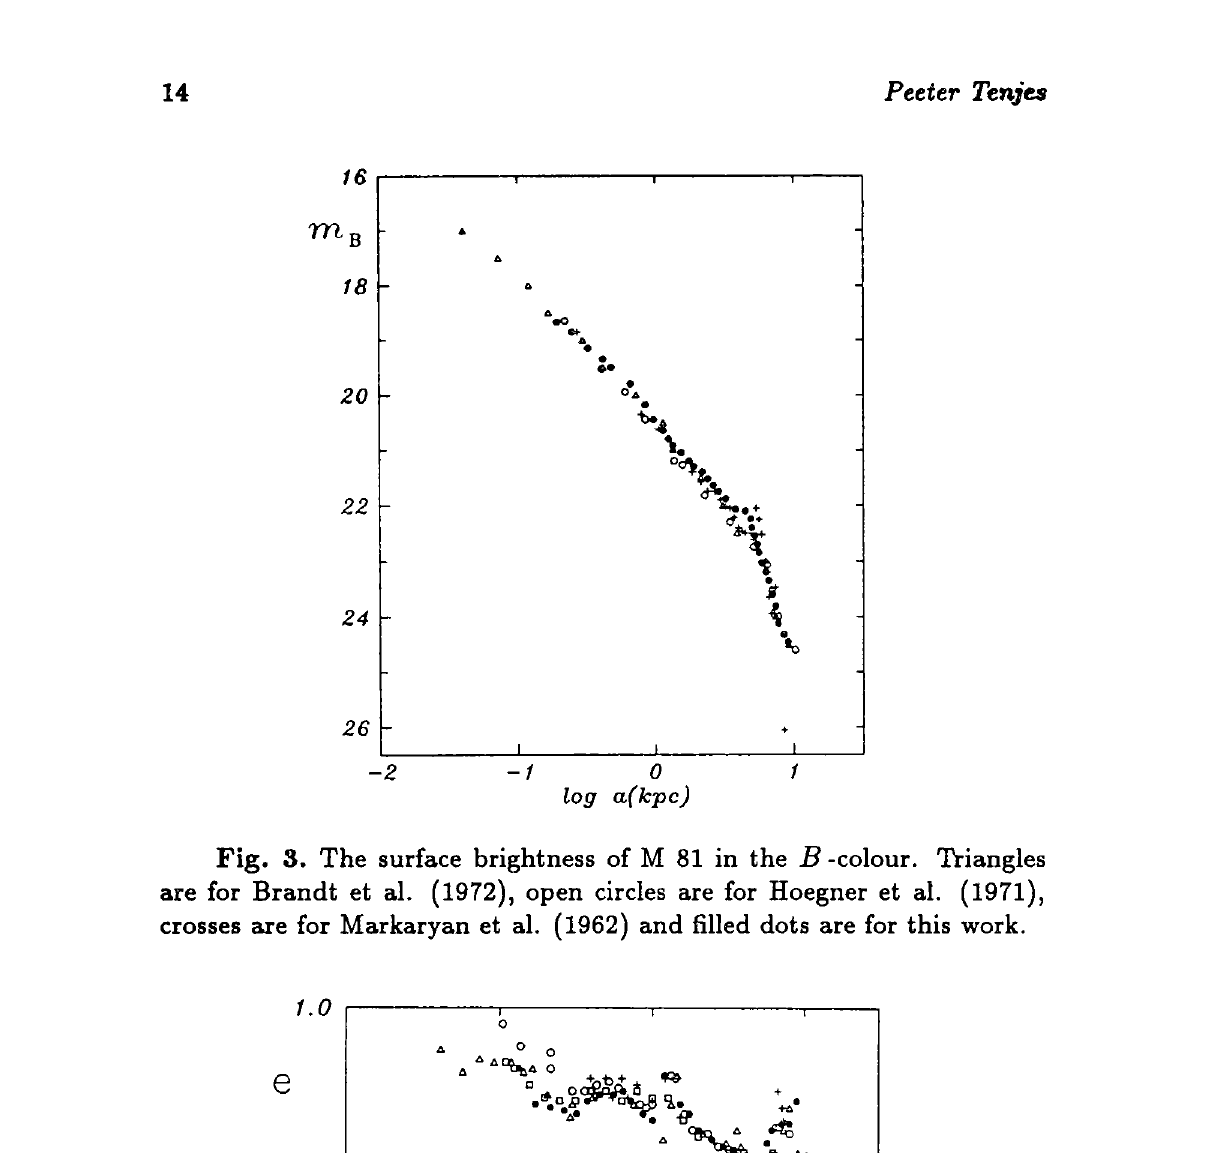
Fig. 3. The surface brightness of M 81 in the B -colour. Triangles are for Brandt et al. (1972), open circles are for Hoegner et al. (1971), crosses are for Markaryan et al. (1962) and filled dots are for this work.